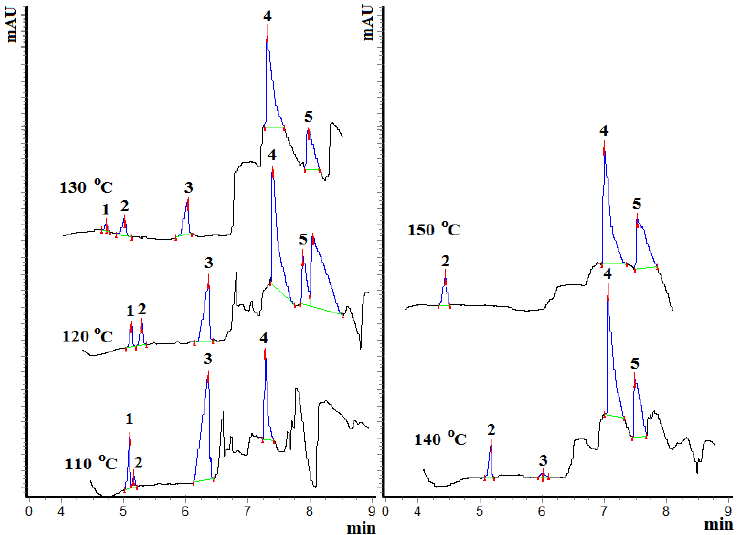
Figure 6. Electrophoregrams of the analysis of the catalyzate obtained at different reaction temper- atures: 1—cellobiose; 2—glucose; 3—cellobionic acid; 4—gluconic acid; 5—glucaric acid (cellobiose,